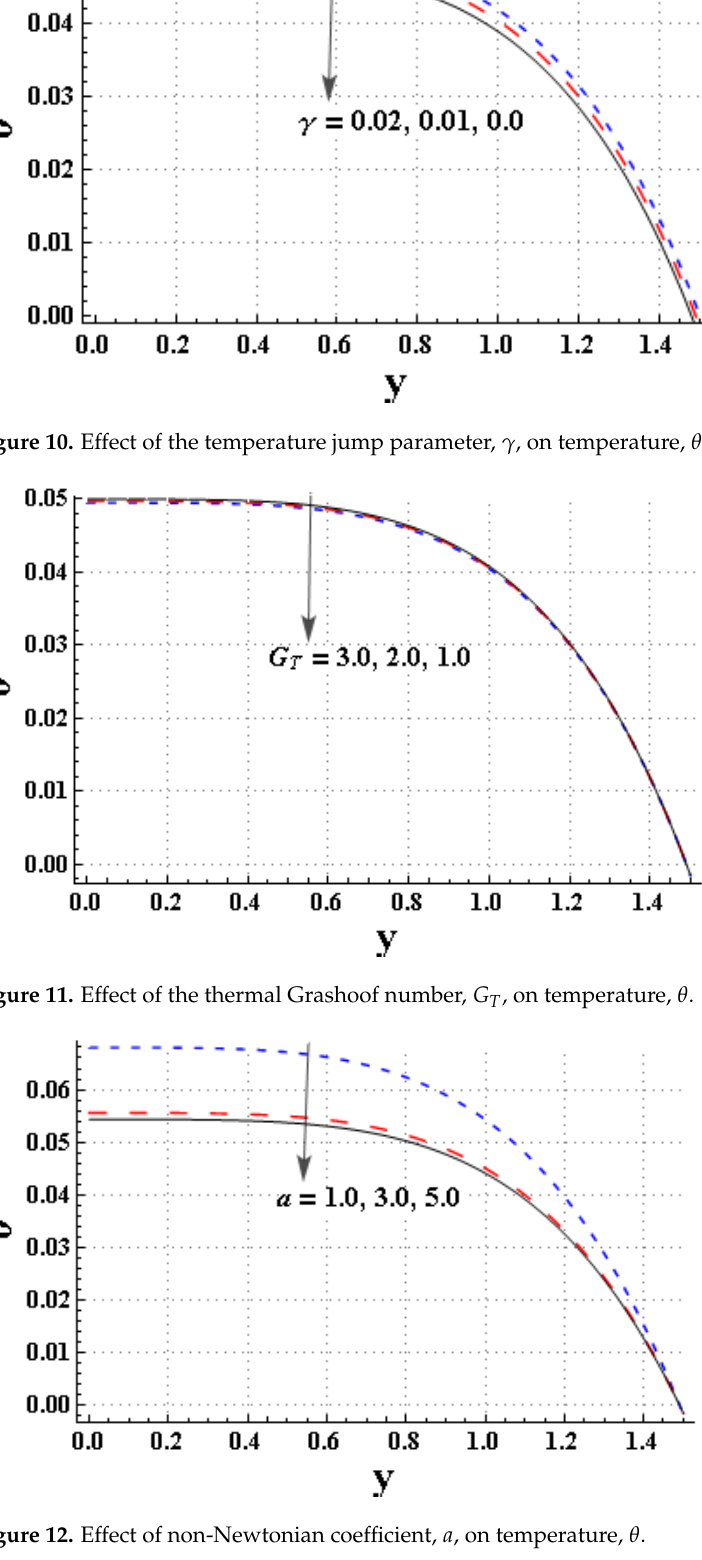
Figure 12. Effect of non-Newtonian coefficient,